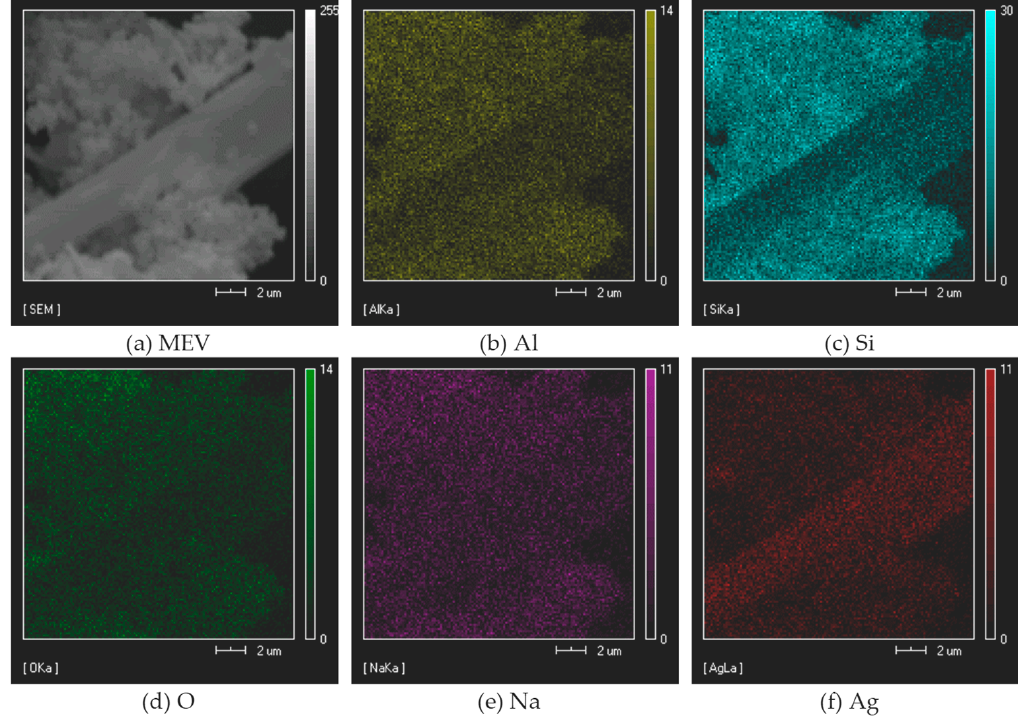
Figure 1. Component performed by X-ray spectrometer probe (EDX) for the zeolite AgSD-Y. ( a ) original image; ( b ) Al; ( c ) Si; ( d ) O; ( e ) Na; ( f ) Ag. Silver sulfadiazine is a large molecule, and its morphology is modified when impregnated in the zeolitic support. Small “needles” of silver sulfadiazine with dimensions of 33.75 µ m in length and 7.14 µ m in width were